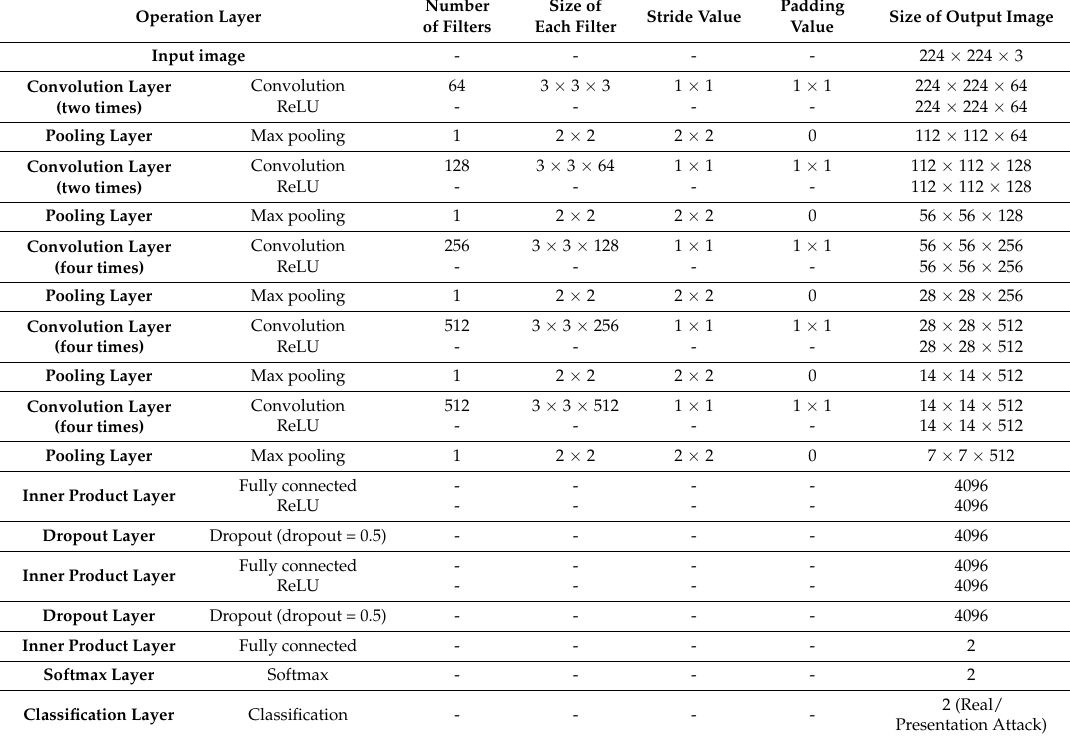
Table 2. Description of convolutional neural network (CNN) architecture used in our iPAD